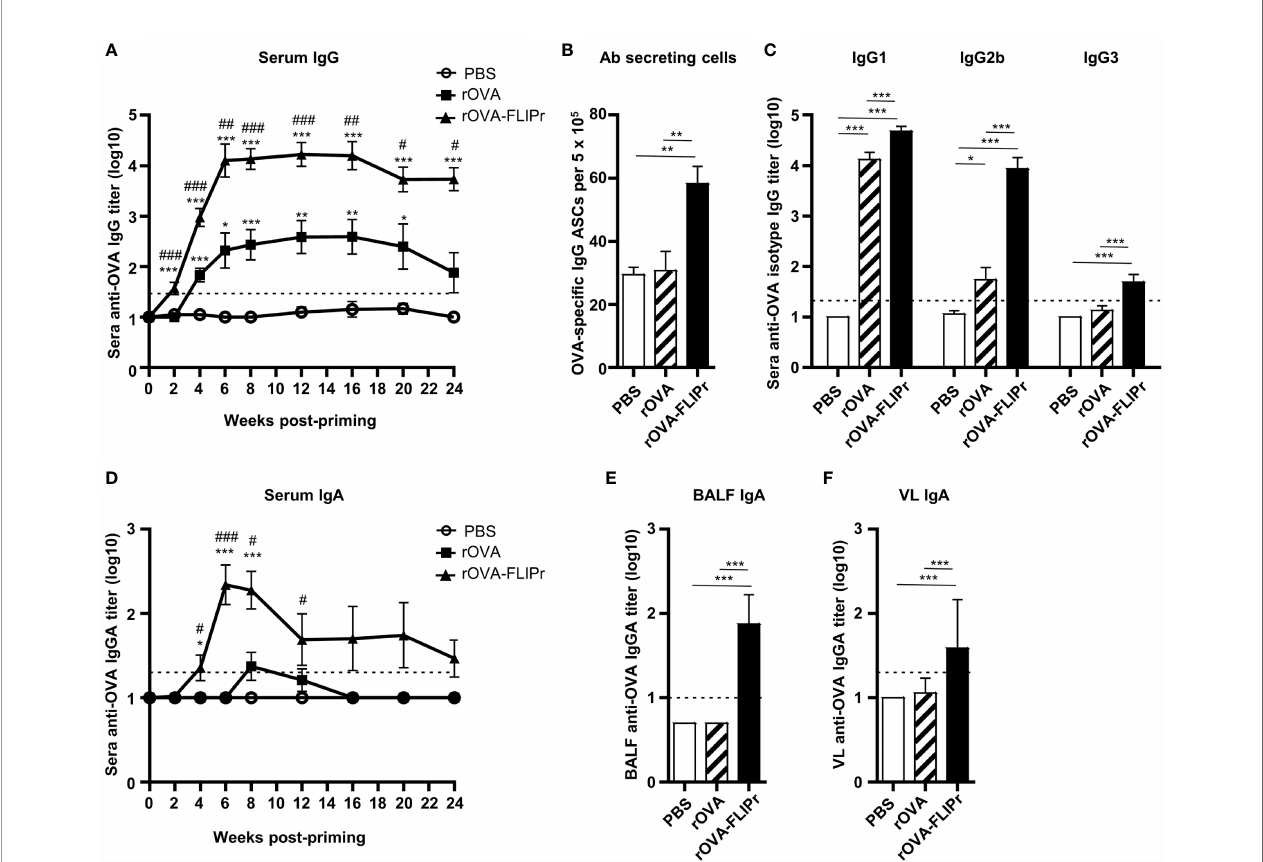
FIGURE 3 | Antibody responses induced by intranasal administration of rOVA-FLIPr. Groups of C57BL/6 mice (n=6/group) were intranasally immunized three times with 30 m g of OVA or OVA-FLIPr in PBS at 2-week intervals. Mice immunized with PBS alone (without antigens) served as controls. Sera were collected at the indicated time points. (A, D) OVA-speci fi c IgG and IgA was assessed by ELISA. Data represent the mean ± SE of the mean. Statistical signi fi cance was determined using the Kruskal-Wallis test with Dunn ’ s multiple comparison test. *p<0.05; **p<0.01; ***p<0.001 v.s. PBS. #p<0.05; ##p<0.01; ###p<0.001 v.s. rOVA. (B) OVA-speci fi c antibody-secreting cells in splenocytes were evaluated using ELISPOT at 24 weeks after the fi rst vaccination. (C) Reactivity of subtype IgG1, IgG2b, and IgG3 antibodies speci fi c to OVA. (E, F) Reactivity of OVA-speci fi c IgA antibody titers in BALF and VL was assessed by ELISA. The BALF and VL were collected 6 weeks after the fi rst vaccination. Data represent the mean ± SE of the mean. The detection limit is indicated by the dotted line on the y-axis, which indicates the initial dilution factor of the sample. Statistical signi fi cance was determined using the Kruskal-Wallis test with Dunn ’ s multiple comparison test. *p<0.05; **p<0.01; ***p<0.001. The results are representative of three independent